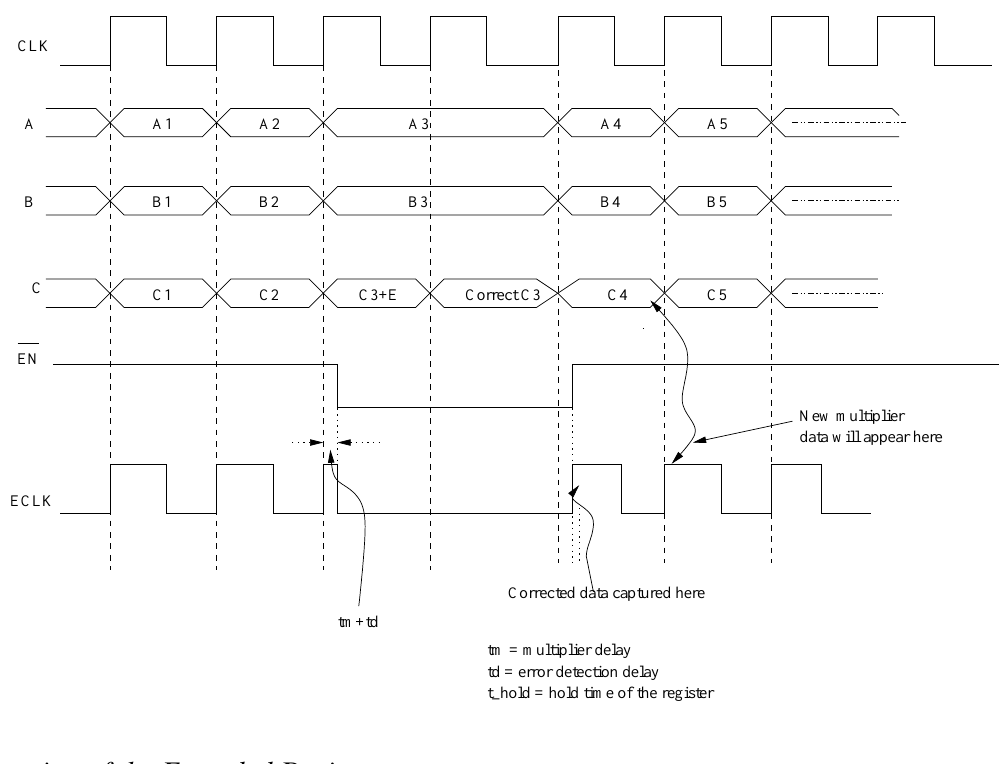
Figure 6. Timing Diagram of the Proposed Radiation Hardened Architecture.